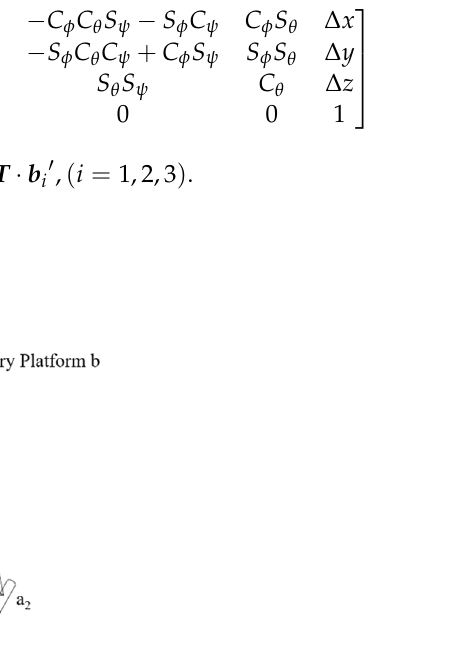
Figure 9. Schematic diagram of 3RPS rotary part.